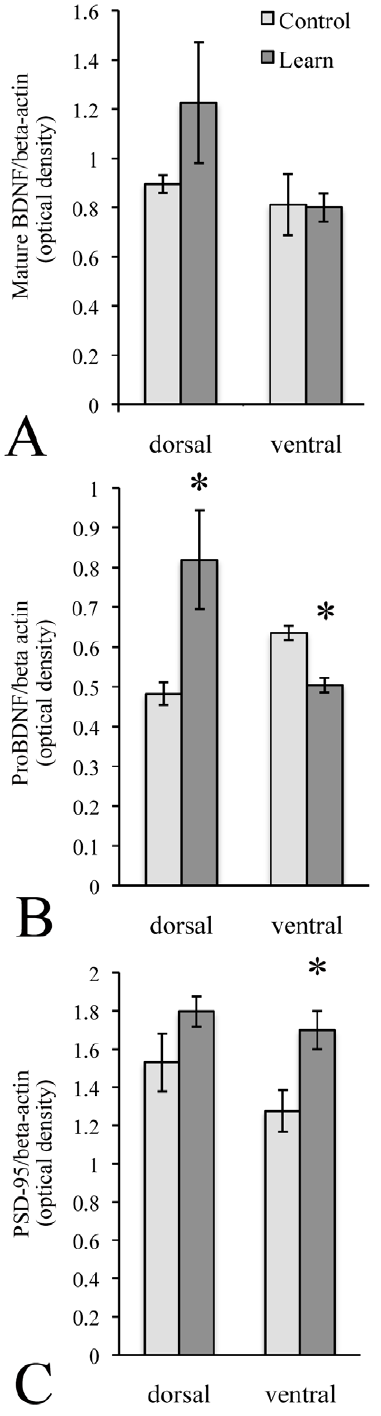
Figure 4. A stressful spatial navigation task differentially affected protein expression in the dorsal and ventral sub- regions. Expression of mature BDNF was not significantly changed by RAWM exposure in either the dorsal or ventral dentate gyrus (A). In contrast, proBDNF was significantly increased in the dorsal dentate, and significantly decreased in the ventral (C). PSD-95 was unchanged in the dorsal, but significantly increased in the ventral dentate (C). * significantly different from